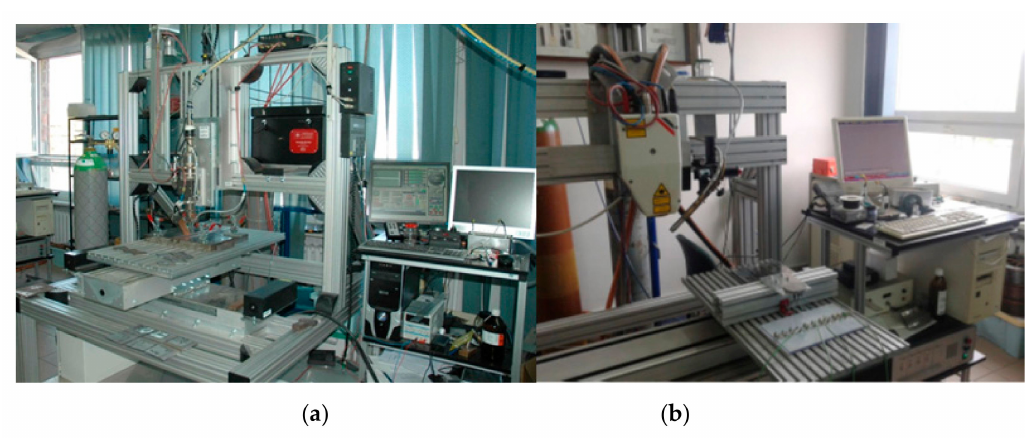
Figure 5. View of test stands equipped with ( a ) TruDisk 3302 disk laser with 3300 W laser beam power and ( b ) a Rofin DL020 high-power diode laser with 2200 W beam power.